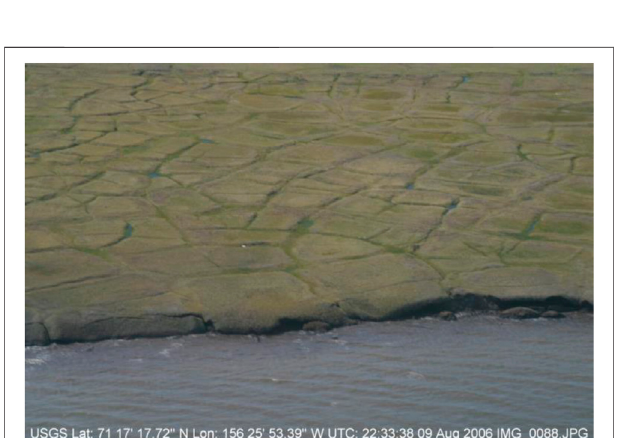
FIGURE 8 | Example photo of coastal bluffs where niche erosion/block collapsewasthepredominantmechanism(imagecourtesyofAnnGibbs,U.S. Geological Survey).